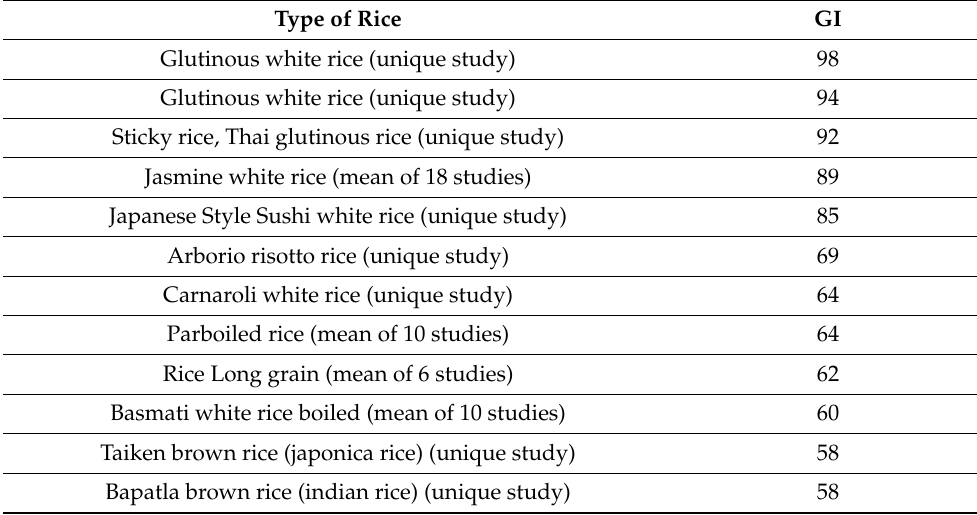
Table 3. Glycemic index (GI) values of different varieties of cooked rice according to ISO 26642:2010 1 . Type of Rice GI Glutinous white rice (unique study) 98 Glutinous white rice (unique study) 94 Sticky rice, Thai glutinous rice (unique study) 92 Jasmine white rice (mean of 18 studies)